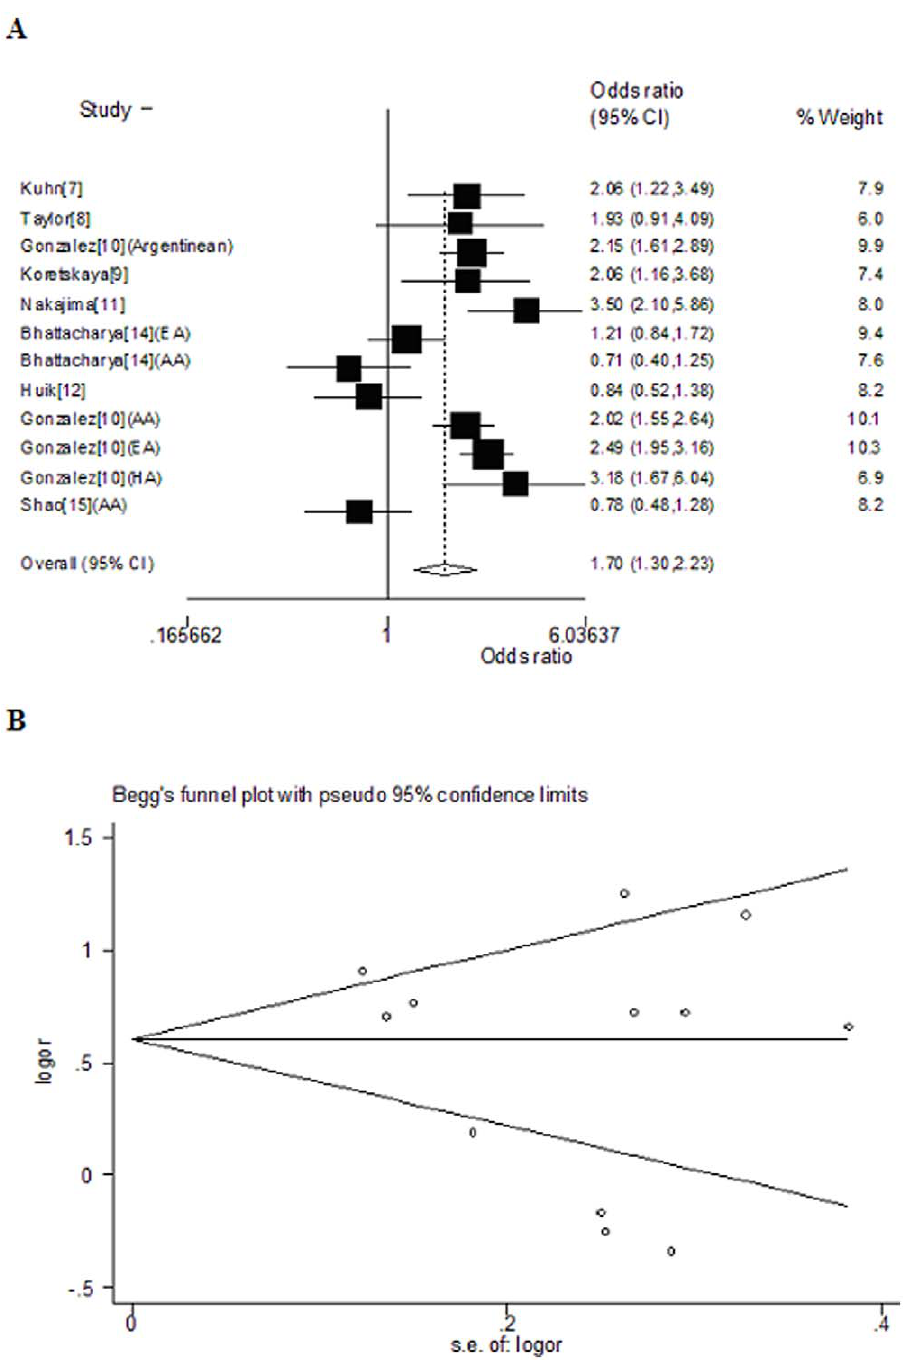
Figure 3. By using the GCN , PMN Vs. CCL3L1 GCN $ PMN model, (a) forest plot of overall analysis; (b) funnel plot to detect publication bias in overall analysis. Data of studies involving mixed race was set apart according to different ethnicity.